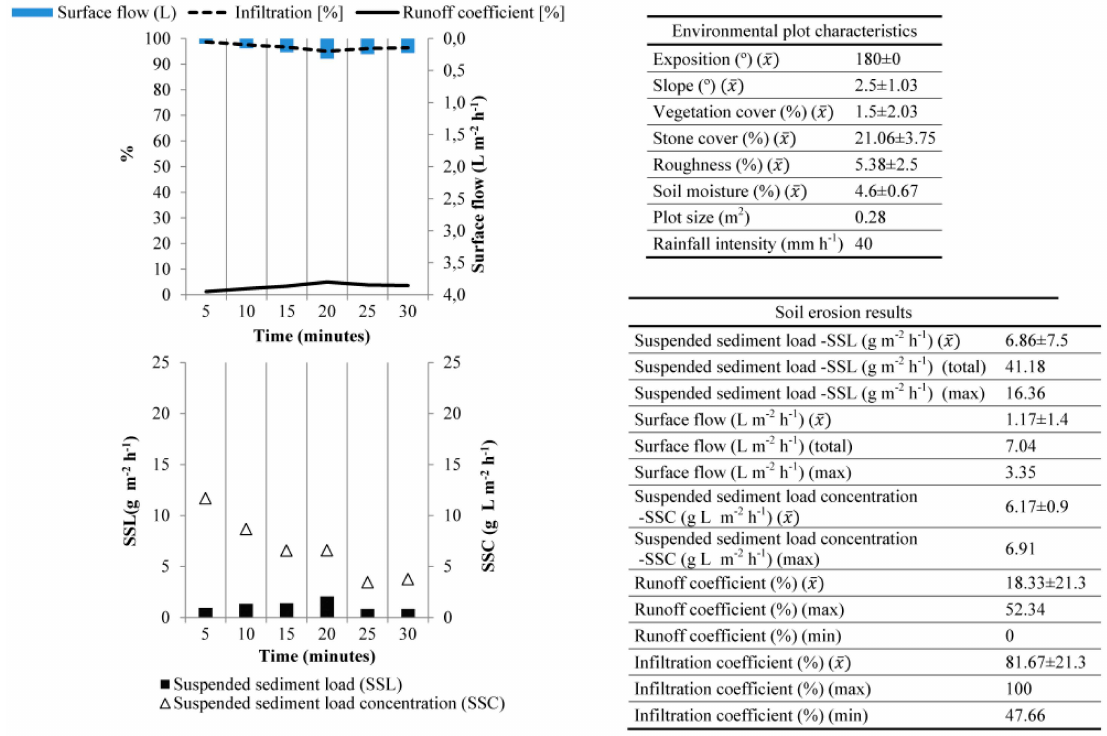
Figure 6. Rainfall simulations in Moixent (Valencia,